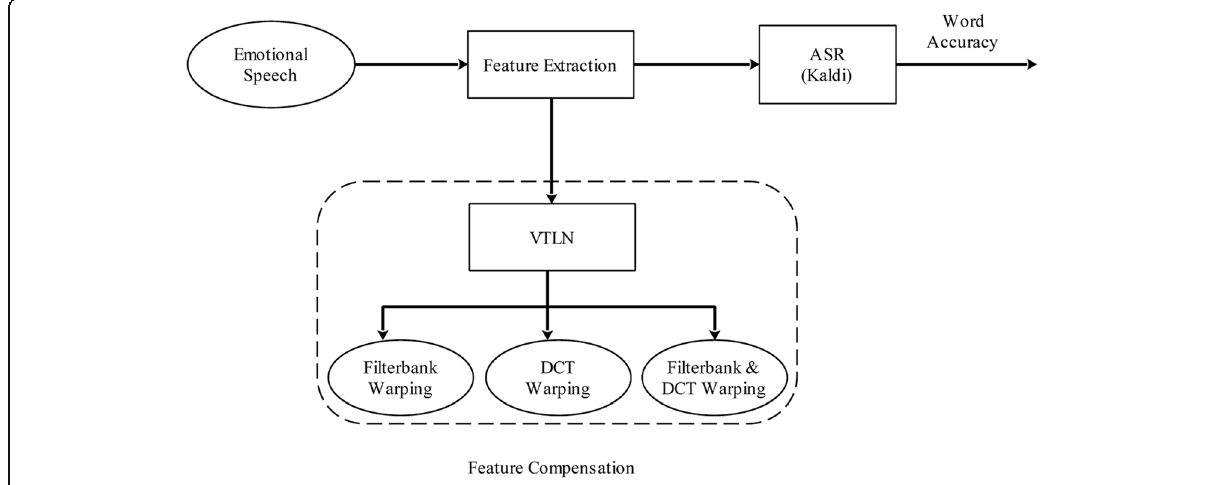
Fig. 1 The general structure of the proposed EASR